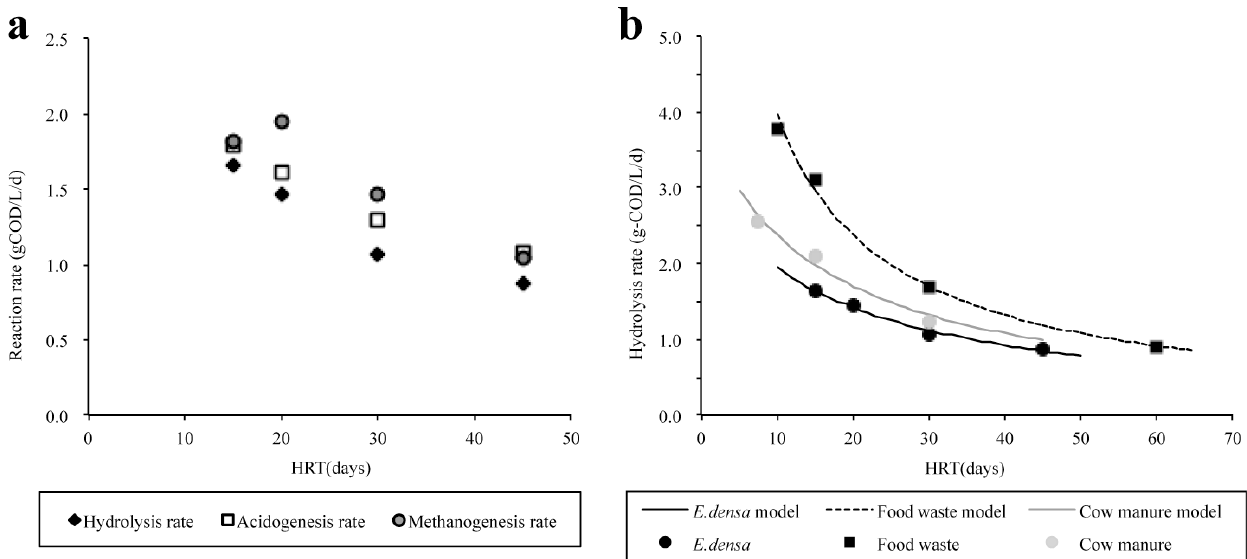
Figure 3. ( a ) The reaction rates of hydrolysis, acidogenesis and methanogenesis in the semi-continuous experiment; ( b ) The hydrolysis rate variations based on acid-phase